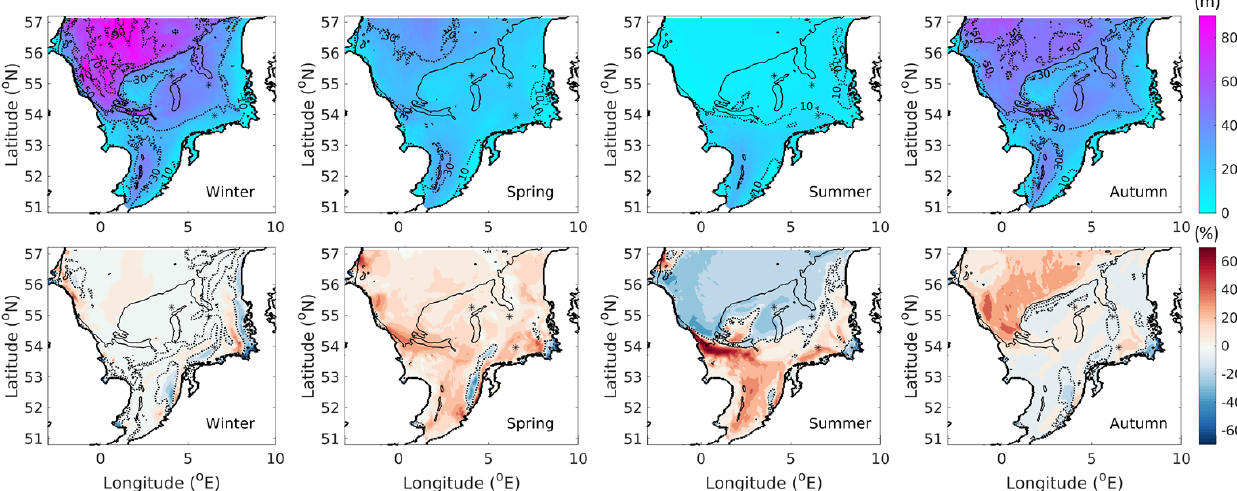
Figure 12. Upper panels: the seasonal mean mixed layer depth (MLD) of the coupled NEMO-WAM model run. Lower panels: the relative changes in the MLD when comparing the coupled run with the stand-alone NEMO (uncoupled) run. Dotted lines in the lower panels indicate the 0% contour.